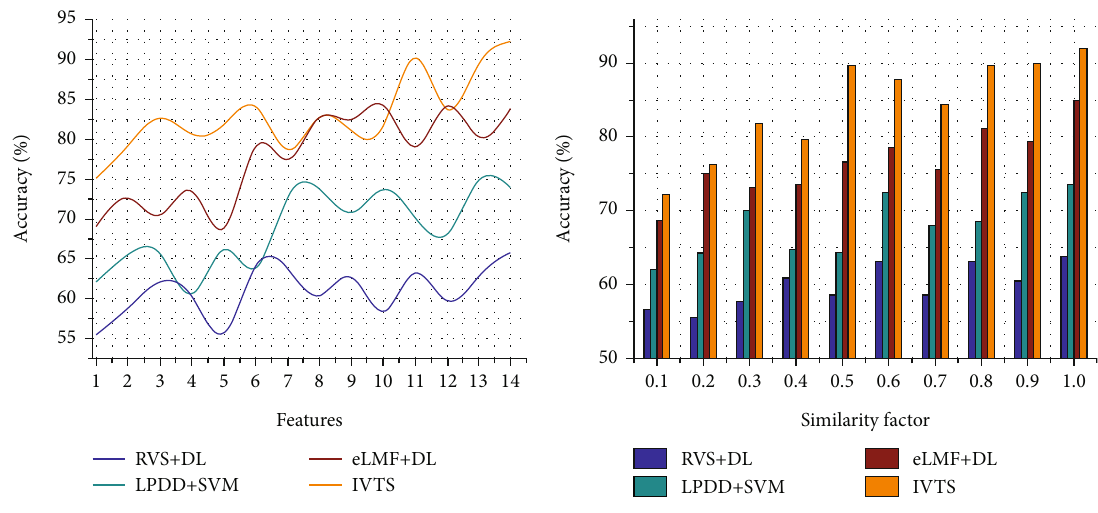
Figure 8: Accuracy